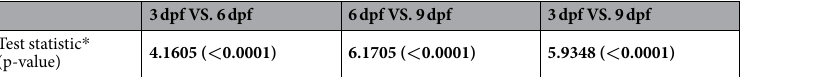
Table 5. The Hotelling’s T-squared test of Light-On VMR data used in Table 4. * These results are reproduced from 31 for